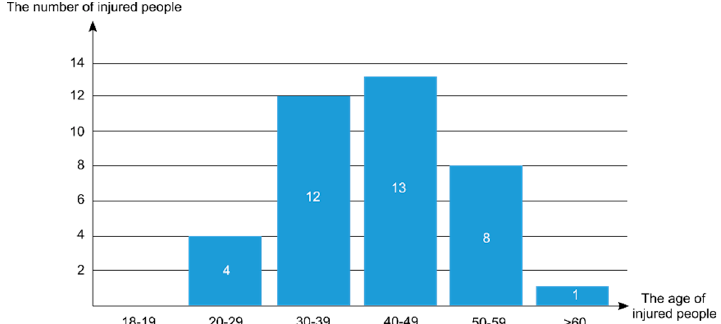
Figure 4. Age structure of injured people who were under the influence of alcohol based on control protocols (own elaboration).